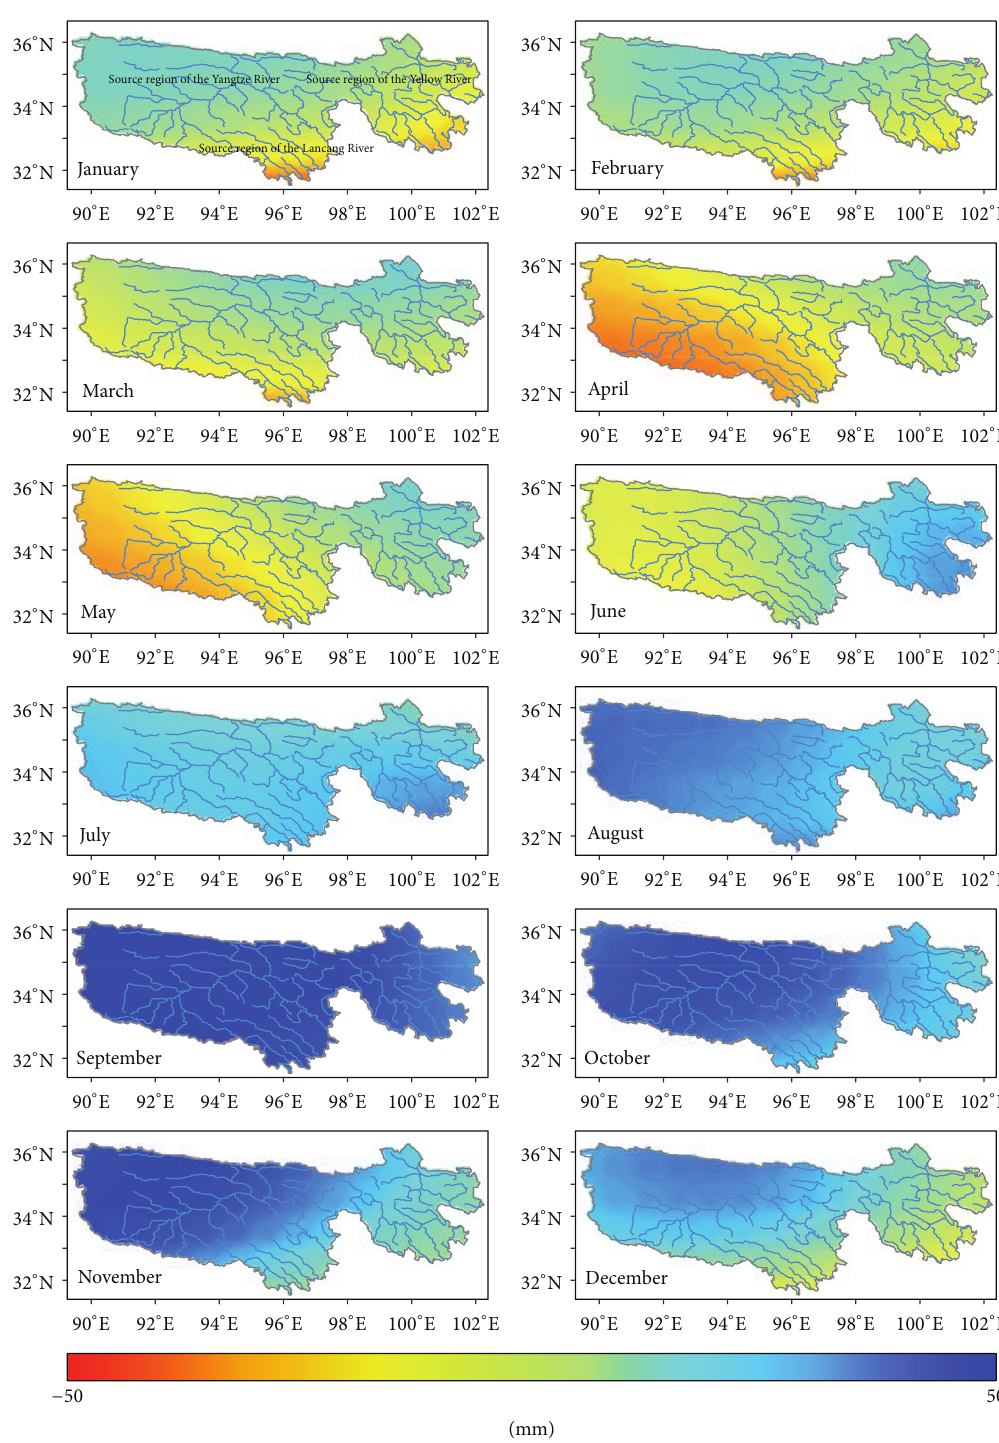
Figure 4: Monthly averages of water storage change during